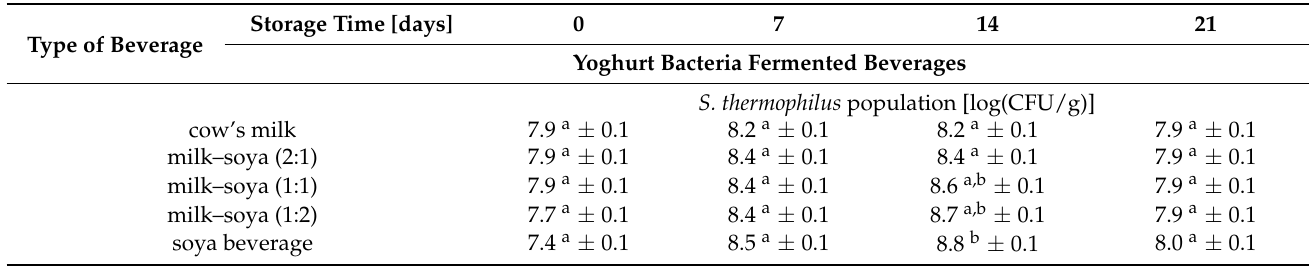
Table 3. Microflora population of milk, milk–soya, and soya yoghurt products obtained from beverages fermented using different starter cultures and stored at 5 ◦ C for 21 days (mean values and standard